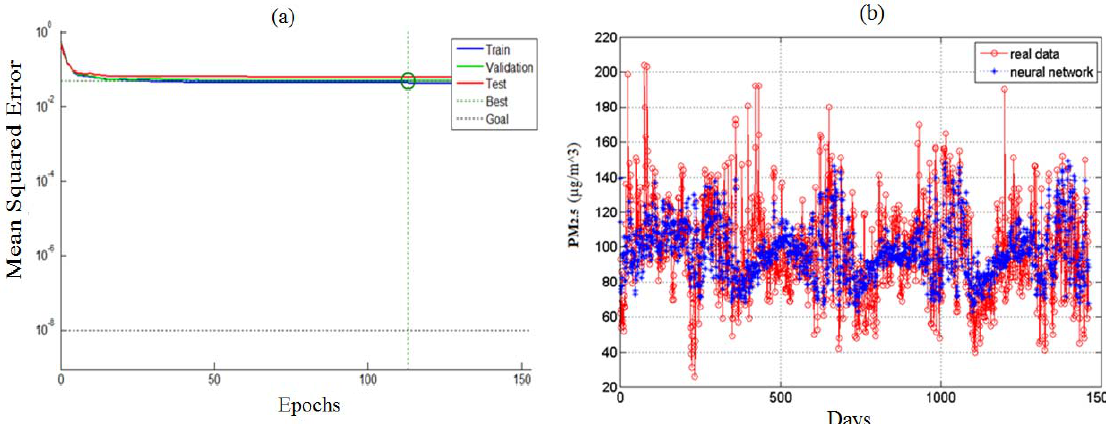
Fig. 5: (a) MSE values for training, validation and test (b) Schematic showing of the predicted and observed concentrations of PM 2.5 data